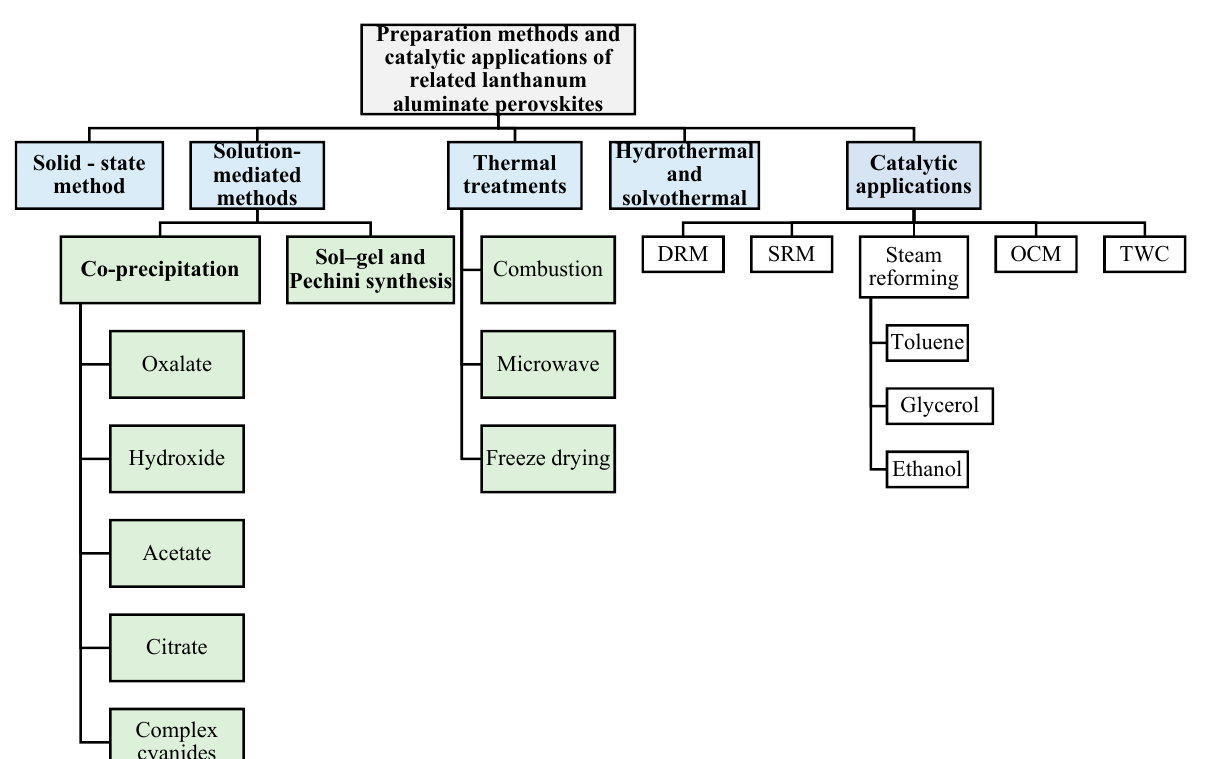
Figure 1. Synthesis and catalytic applications of related LaAlO 3 perovskites.